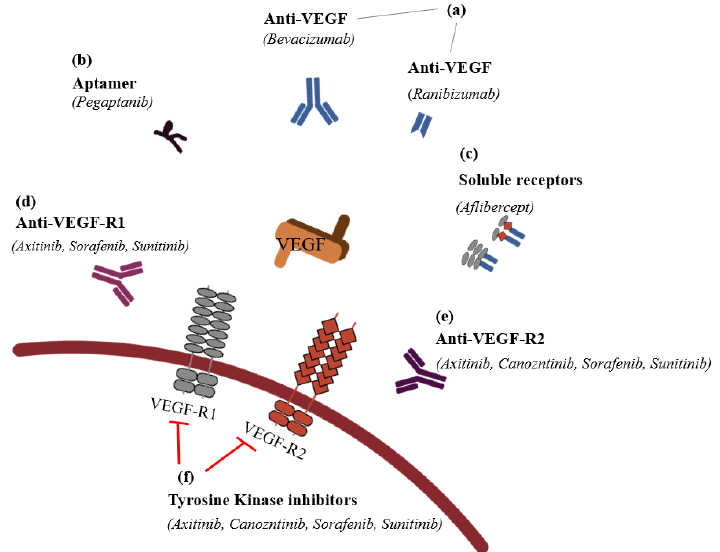
Figure 4. The classification of anti-vascular endothelial growth factors (modified from Noel et al., 2007 [84]). ( a ) VEGF antibodies directly bind the VEGF to inhibit its activation; these antibodies include humanized antibodies, such as bevacizumab (Avastin TM ), and fragment of humanized antibodies, such as ranibizumab (Lucentis TM ). ( b ) Apamers adhere on the VEGF to act like VEGF antibodies, and pegaptanib (Macugen TM ) is the representative drug in this category. ( c ) In order